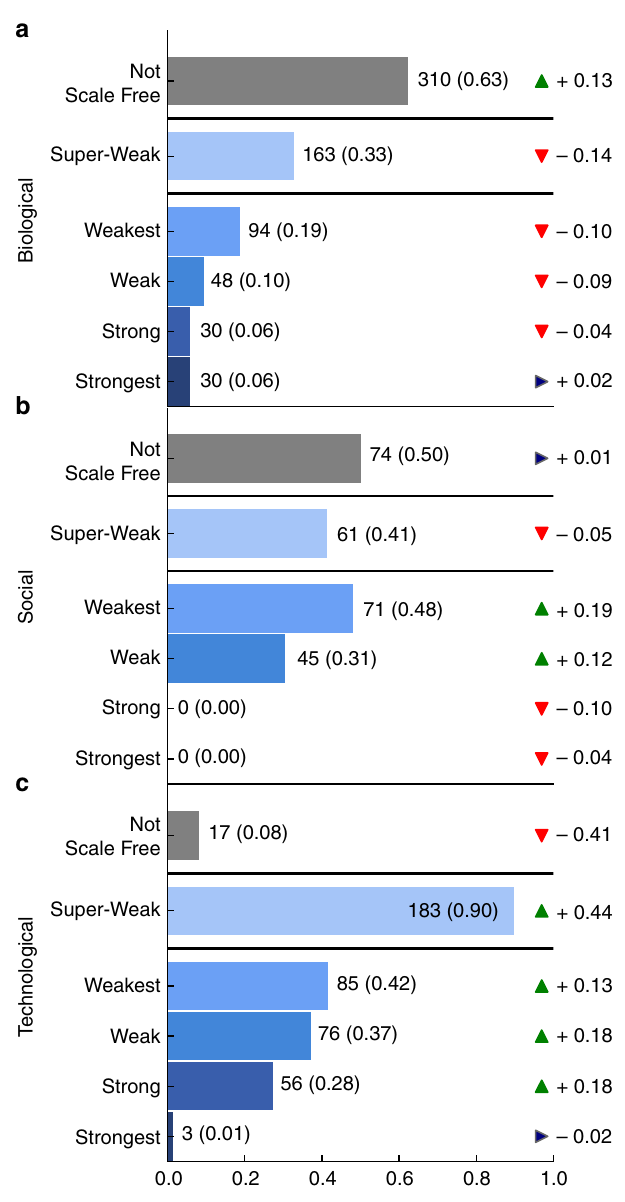
Fig. 5 Proportion of networks by scale-free evidence category and by domain. a Biological networks, b social networks, and c technological networks. Tickers show change in percent from the pattern in all of the data distribution networks. Among the categories representing direct evidence, less than half exhibit the weakest form of direct evidence (42% Weakest). This group includes roughly half of CAIDA ’ s networks of autonomous systems, several digital circuit networks, and several peer-to-peer networks. In contrast to biological or social networks, however, technological networks exhibit a modest fraction with strong direct evidence of scale-free structure (28% Strong). Networks in this category include the other half of the CAIDA graphs. But, almost none of the technological networks exhibit the strongest level of direct evidence (1% Strongest).